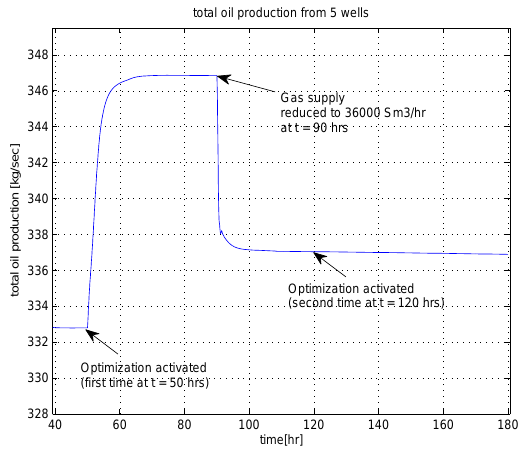
Figure 10: Total oil production when optimization was performed for the second time after input disturbance